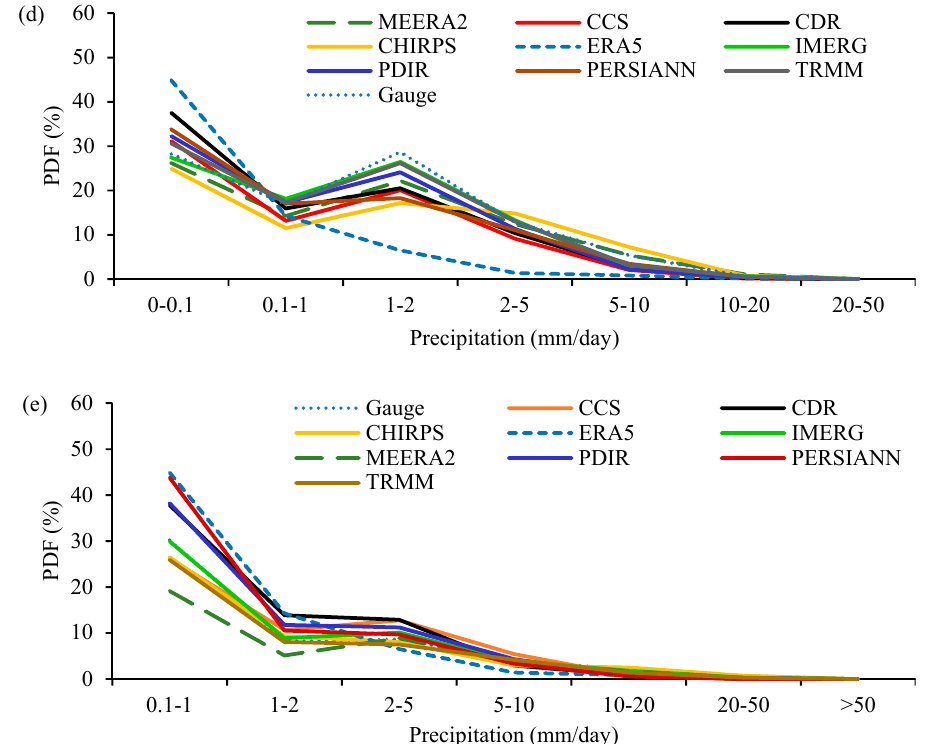
Figure 18. Probability density function of reanalysis and SPPs (CCS, CDR, CHIRPS, ERA5, IMERG, MEERA2, PDIR, PERSIANN, and TRMM) estimated for different intensities of ( a ) daily, ( b ) winter, ( c ) spring, ( d ) summer, and ( e ) autumn precipitation in Pakistan.